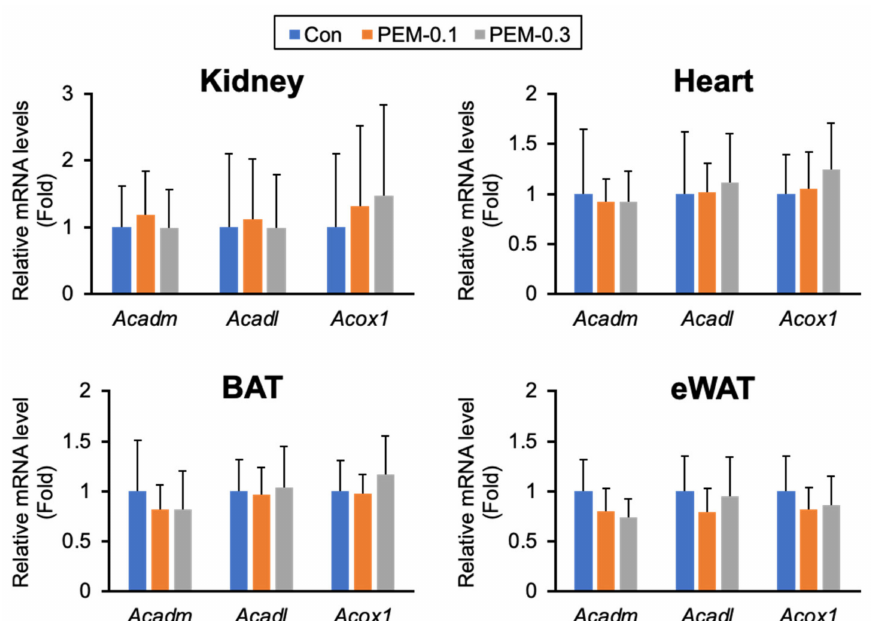
Figure 7. Clinically relevant dose of PEM does not induce PPAR α target genes in extrahepatic tissues. Expression levels of PPAR α target genes ( Acadm , Acadl , and Acox1 ) in the kidney, heart, BAT, and eWAT. Data are expressed as the mean ± SD. Con, vehicle-treated mice; PEM-0.1, pemafibrate-treated mice at a clinically relevant dose (0.1 mg/kg/day); PEM-0.3, pemafibrate-treated mice at a relatively high dose (0.3